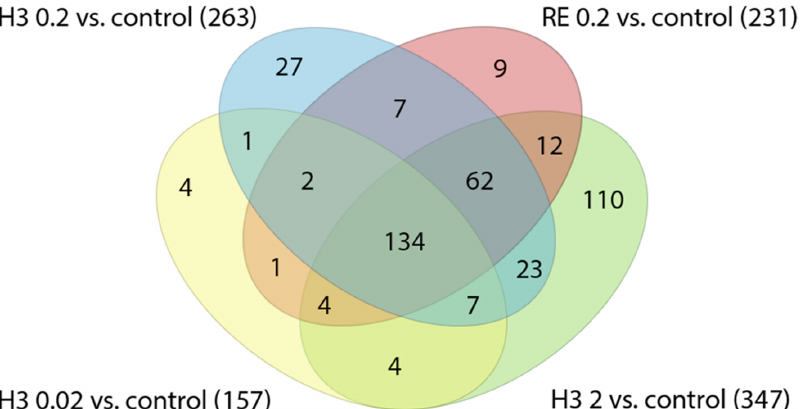
Fig 1. Venn diagram showing the number of differentially regulated genes per treatment vs. the untreated negative control (DMSO 1%). H3: OPC enrichedfraction “H3”; RE: crude extract (ethanol: water 1:1). 0.02, 0.2 and 2: concentrations of 0.02 mg/mL, 0.2 mg/mL and 2 mg/mL resp., per treatment. Numbers in brackets indicatethe number of differentiallyregulatedgenesper group.